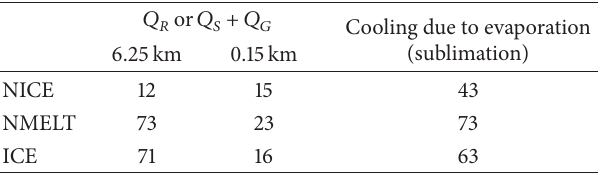
Table 3: Amount of rainwater or the sum of snow and graupel at 6.25km and 0.15km and Cooling due to evaporation (sublimation) in the lower layer below 3 km height. The numerals are given in certain